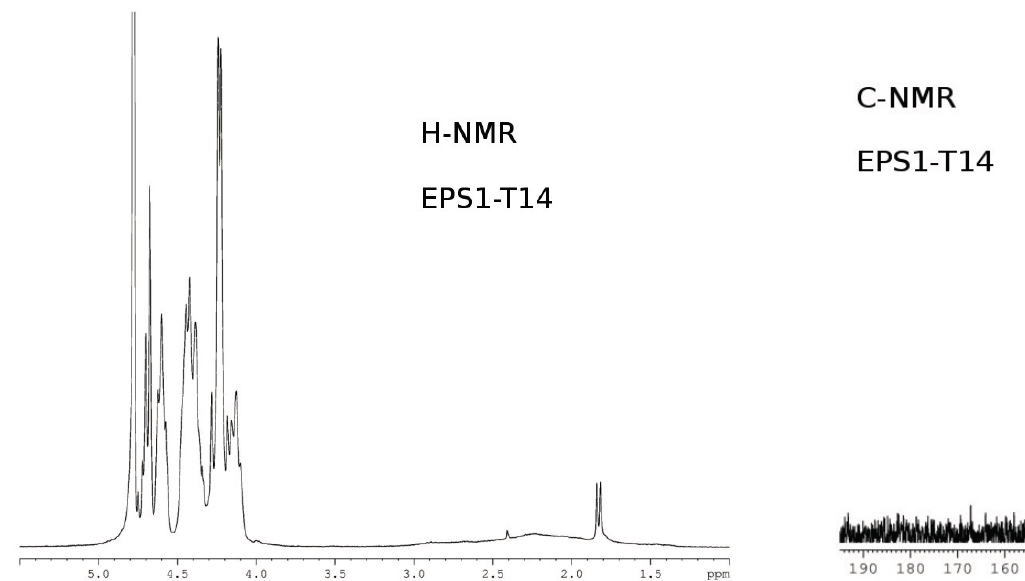
Figure 4. 1 H-NMR and 13 C-NMR spectra of EPSs